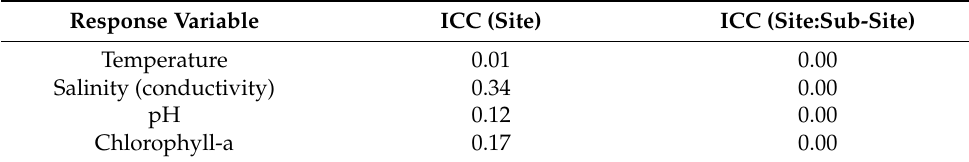
Table 4. Intraclass correlations (ICC) in the intercept-only models.